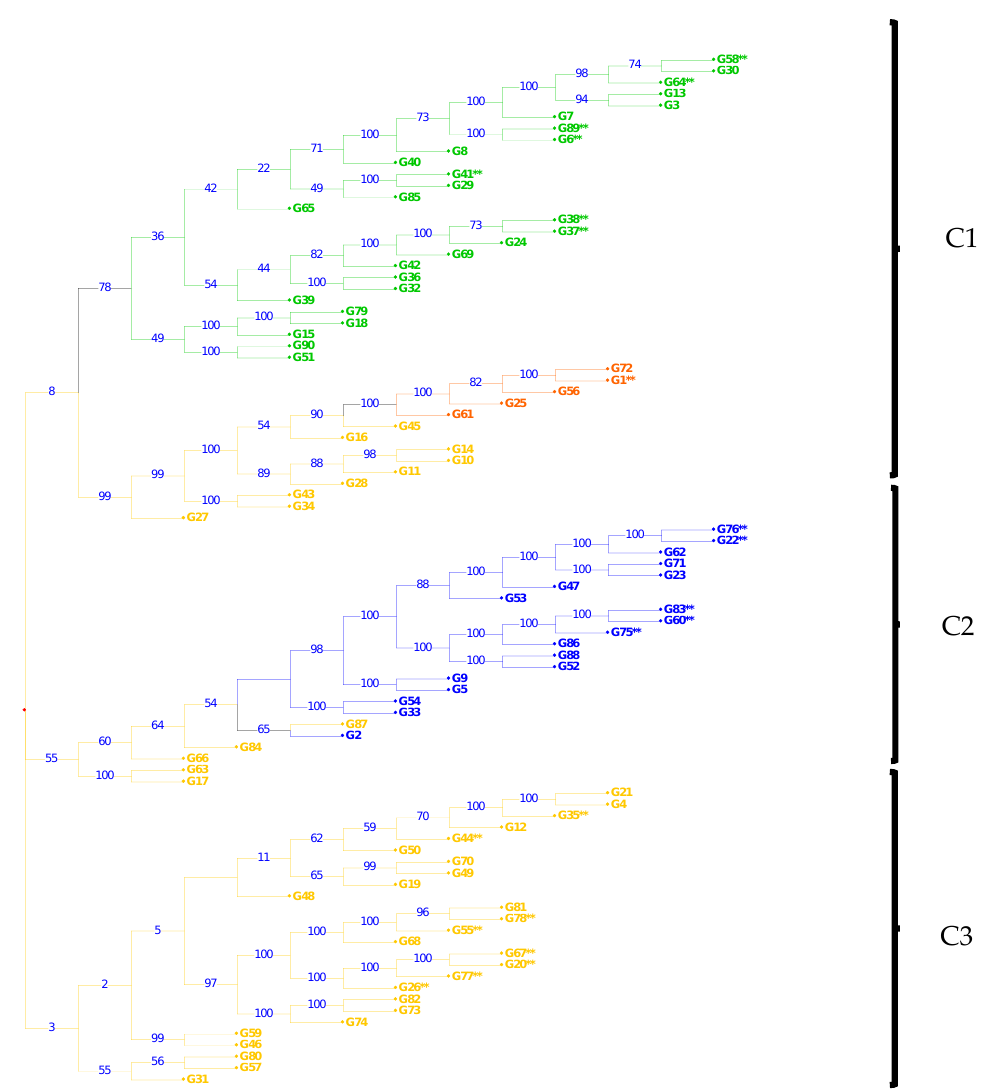
Figure 2. Neighbor joining analysis showing the genetic relationships among 90 cowpea accession tested using 5864 SNP markers. The different colors indicate the clustering generated by STRUCTURE analysis: SP1 = red, SP2 = orange, SP3 = green, and SP4 = blue. ** represents the pure varieties identified in STRUCTURE analysis.